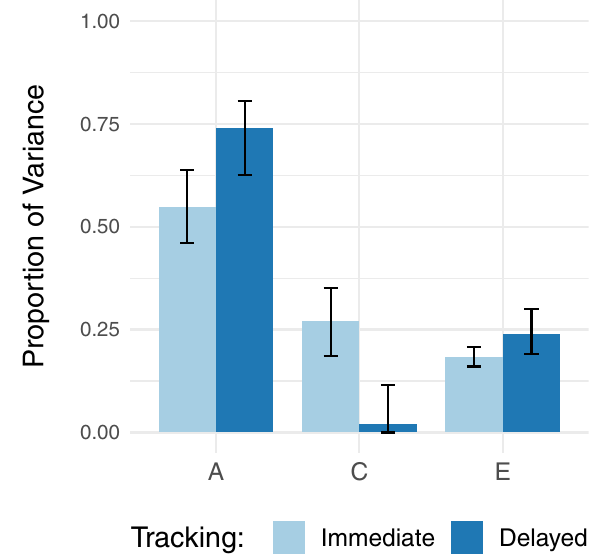
Fig. 1 Genetic and environmental variances of educational attainment for the immediate versus delayed tracking group. Genetic ( A ), shared environmental ( C ), and non-shared environ- mental ( E ) variances are standardized and the error bars represent their 95% con fi dence intervals.